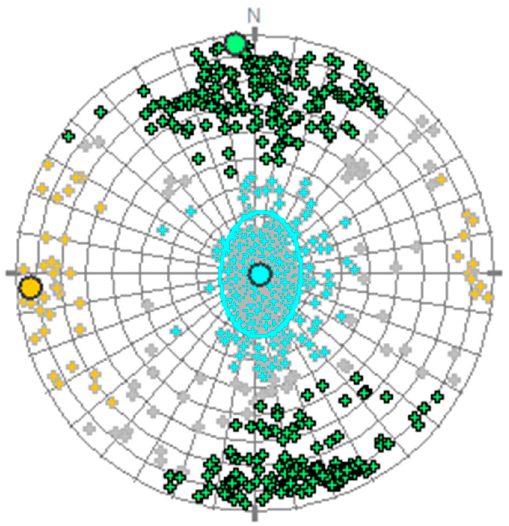
Figure 4. Poles stereo diagram for the bedding (blue), N-S (yellow), and E-W (green) fracture sets.